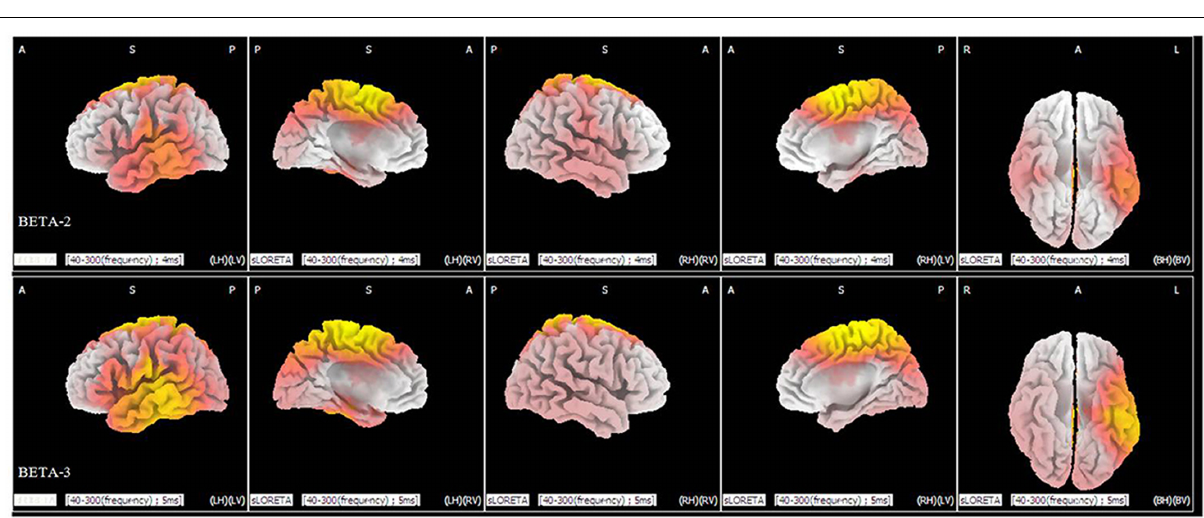
FIGURE 4 | sLORETA differences in two frequency bands (beta 2 and beta 3) between the 40 and 300 ms duration conditions (collapsed across all three congruence conditions). In the beta 2 (upper panel) and beta 3 frequency bands (lower panel), activity was significantly higher for 40 ms than for 300 ms in widespread areas, including the medial frontal gyrus and superior frontal gyrus. Images depicting statistical parametric maps observed from different perspectives are based on voxel by-voxel log of F -ratio values of differences between the two groups for the beta 2 and beta 3 bands. Structural anatomy is shown in gray scale (A, anterior; P, posterior; S, superior; I, inferior; LH, left hemisphere; RH, right hemisphere; BH, both hemispheres; LV, left view; RV, right view; BV, bottom view). Yellow indicates increases for 40 ms compared to 300 ms ( t 0 . 05 = 1.314, t 0 . 01 = 1.510, one tail), which are mainly in the medial frontal gyrus and the superior frontal